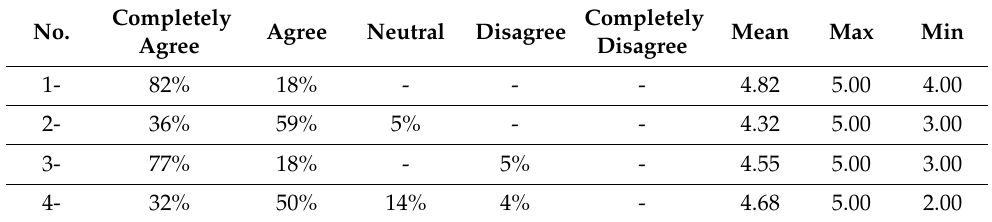
Table 9. The results of the Efficiency parameter.